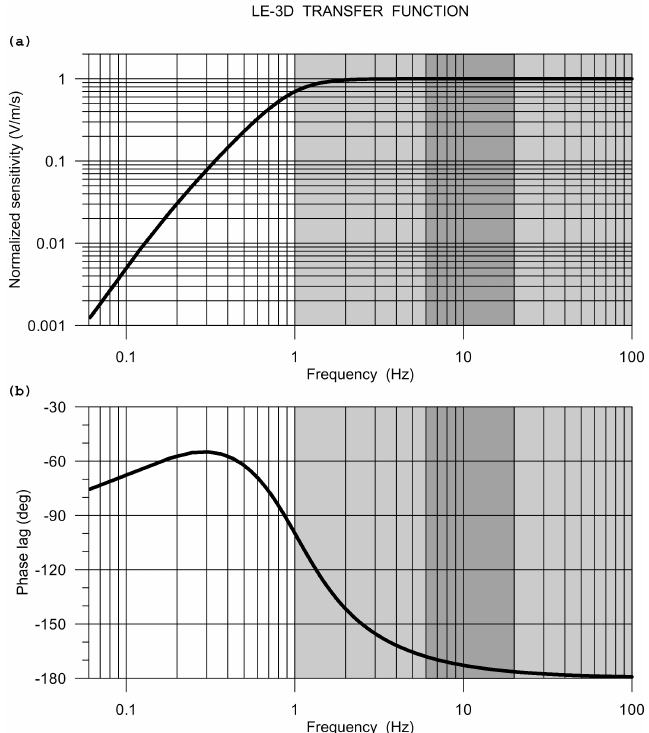
Figure 6. The Lennartz LE-3DLite frequency response: modulus ( a ) and phase ( b ). The response is calculated from poles and zeros specified by the manufacturer. Grey intervals indicate the specified frequency range, the dark grey rectangles mark the range actually considered in the comparative